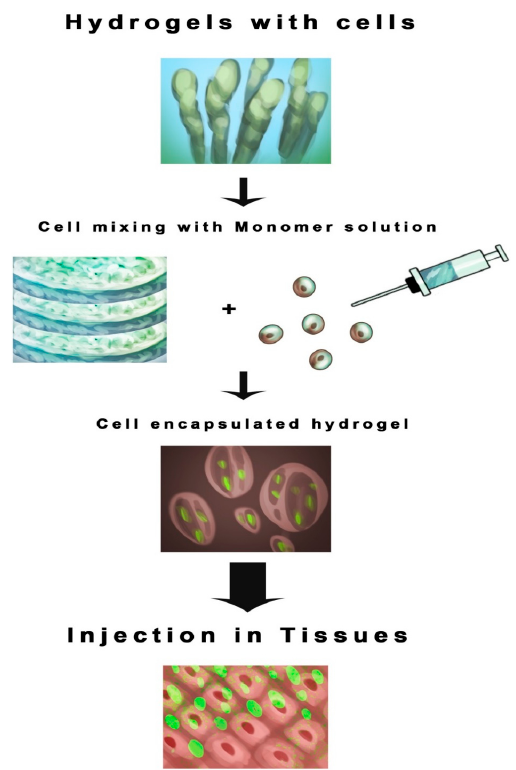
Figure 4. Hydrogel approach. Monomer mixture of a polymeric solution, for example, polyethylene glycol, poly-caprolactone, chitosan, cellulose, etc., are mixed with the skin cells, such as keratinocytes and fibroblasts to generate injectable hydrogels at the wound sites to facilitate wound healing and skin